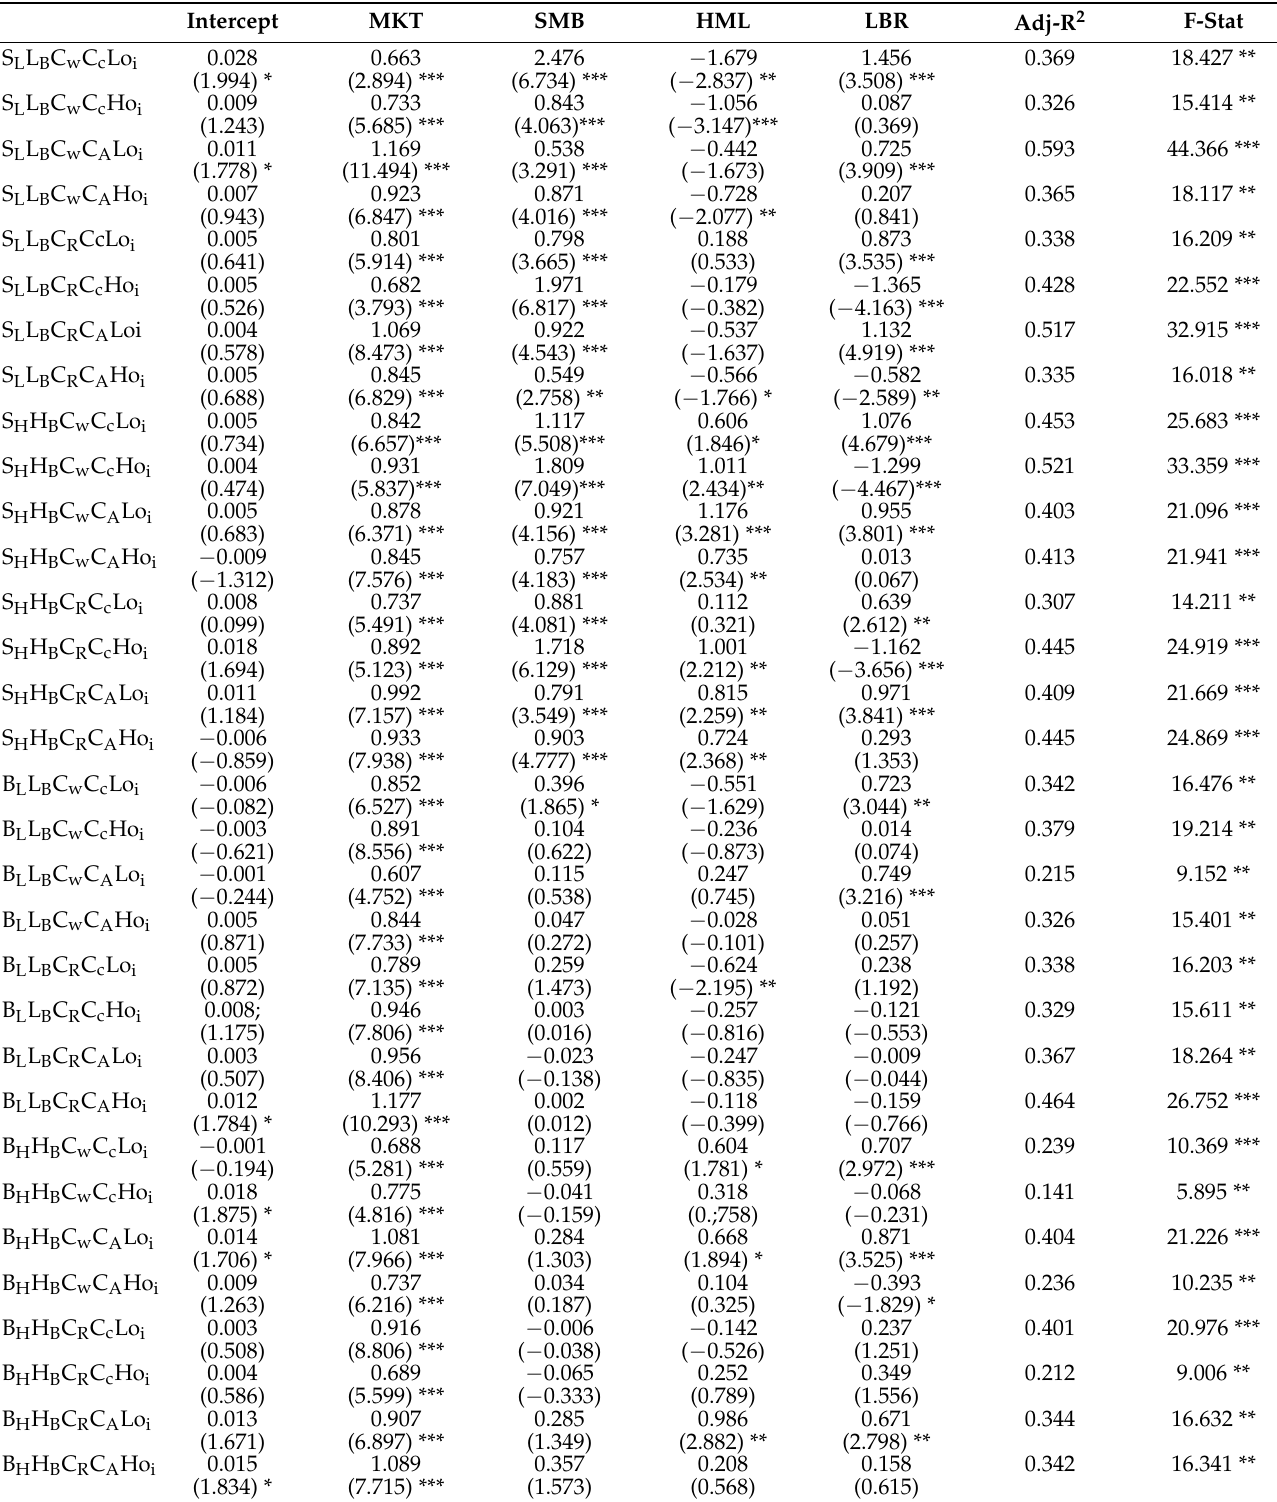
Table 7. Human Capital Four-Factor